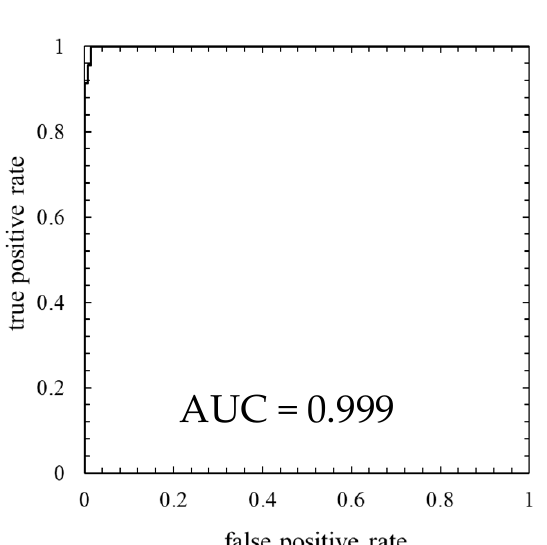
Table 6. Confusion matrix of the model in which the number of mixture components K was 128 (threshold is 100th percentile’s value). Figure 11. True label and assessment result of the model in which the number of mixture components K was 128 (the threshold is the 100th percentile’s value): ( a ) wind speed rotational speed characteristic with true label; ( b ) time characteristics of rotational speed with true label; ( c ) wind speed-rotational speed characteristic with predicted label; ( d ) time characteristics of rotational speed with predicted label; ( e ) time characteristics of anomaly score.